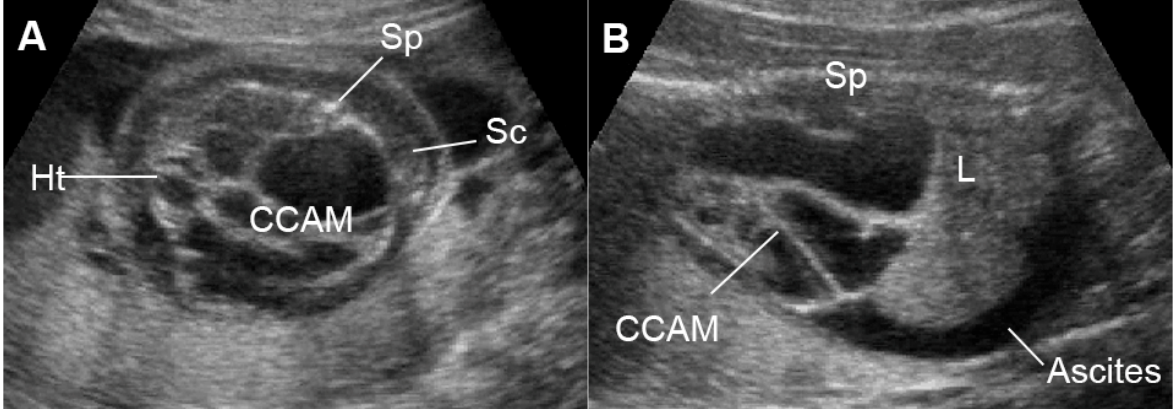
Figure 11. Large cystic adenomatoid malformation (CCAM) type I with hydrops fetalis: ( A ) cross- sectional scan at the four-chamber view: small heart compressed by the cyst and marked subcutaneous edema (Sc); ( B ) sagittal scan of the fetal trunk: CCAM occupying the entire chest and ascites (L: liver; Sp: spine).